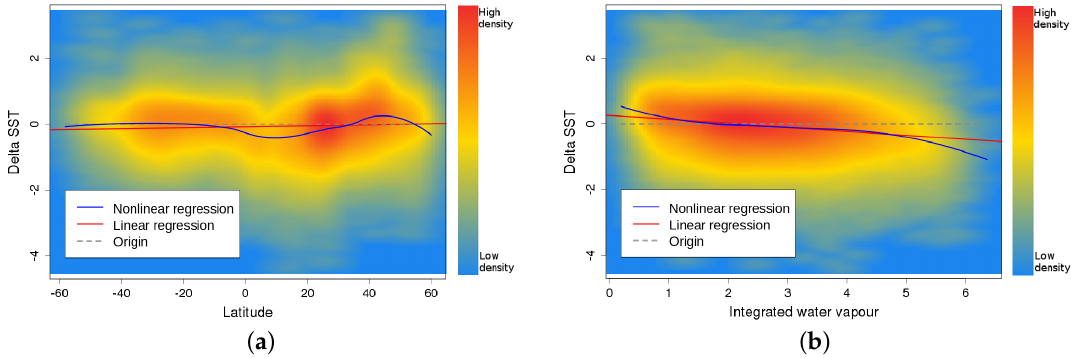
Figure 2. Density scatterplot of ∆ SST as function of ( a ) latitude and ( b ) integrated water vapour fitted using linear and nonlinear (lowess)